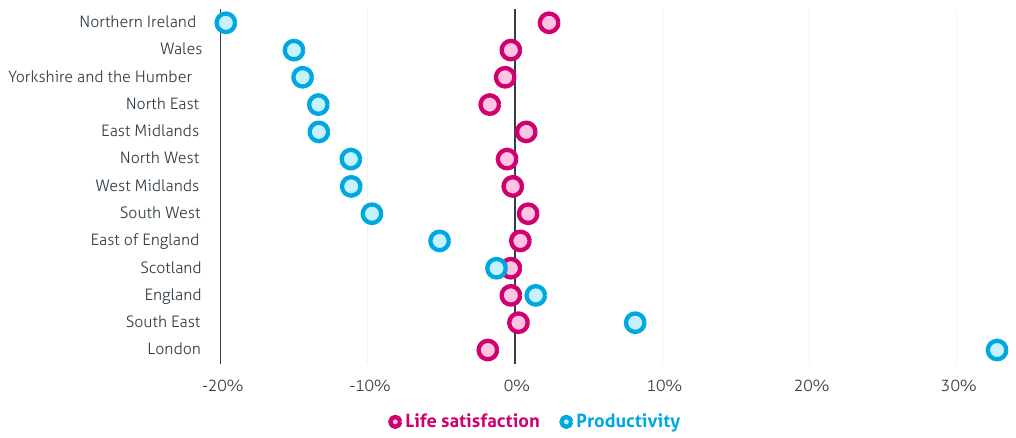
Figure 1 Comparison of regional productivity and life satisfaction against the UK